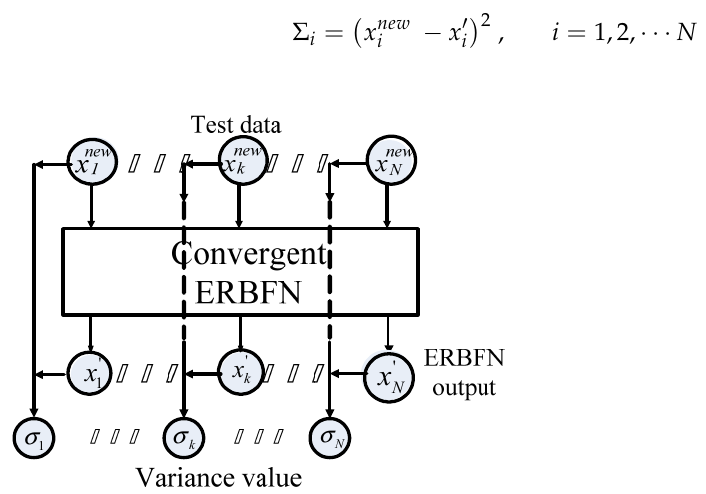
Figure 2. Diagram of ERBFN fault diagnosis.